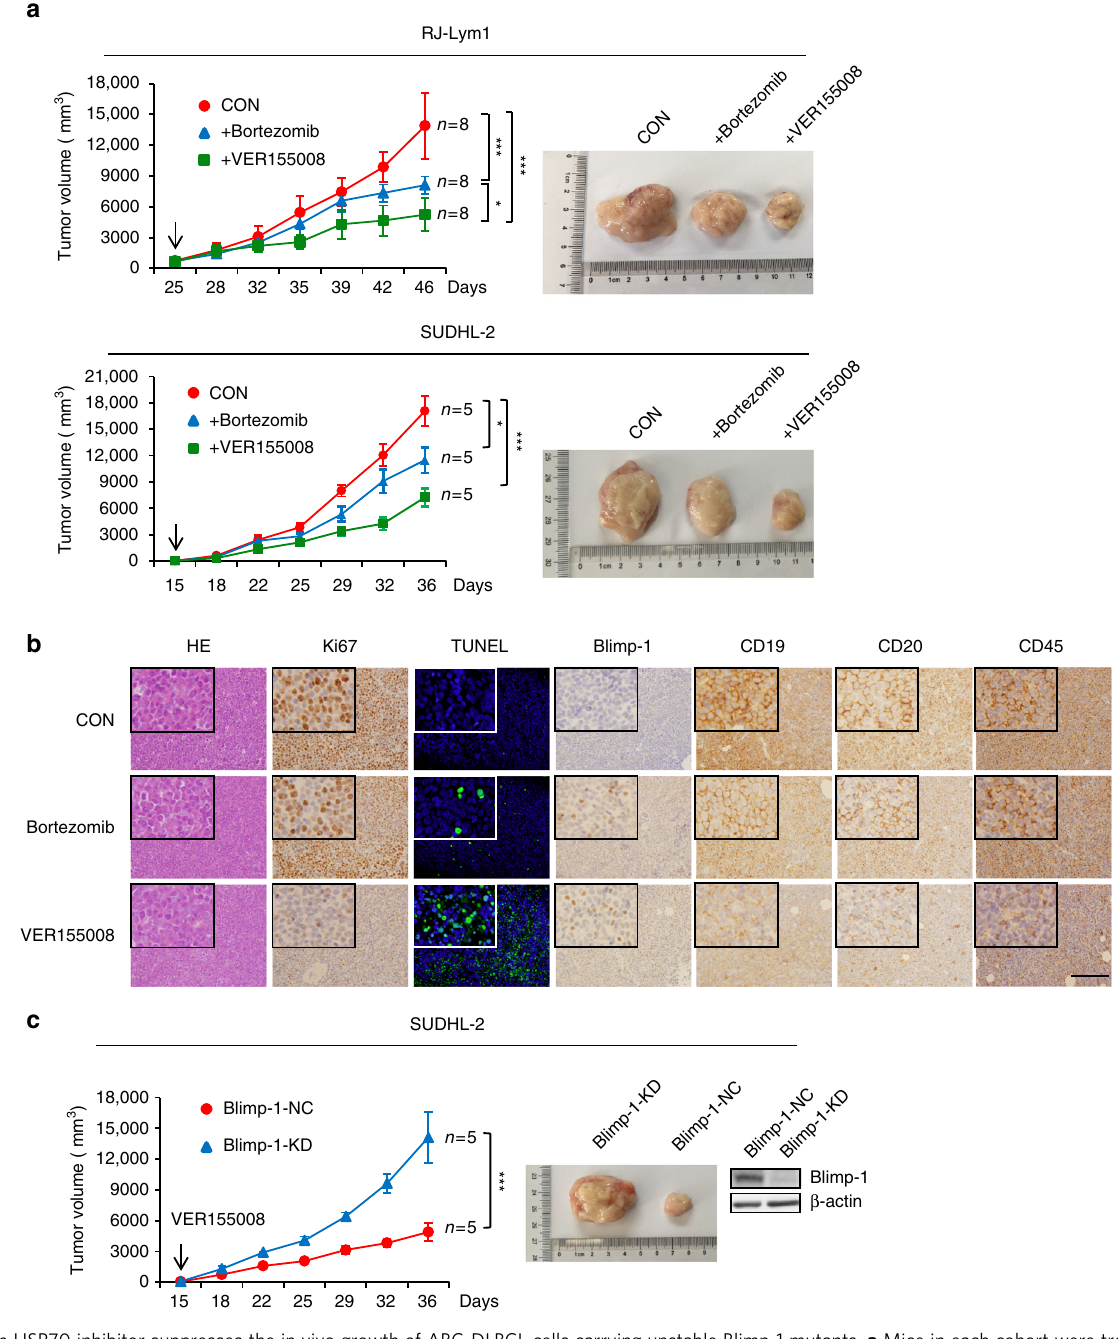
Fig. 7 An HSP70 inhibitor suppresses the in vivo growth of ABC-DLBCL cells carrying unstable Blimp-1 mutants. a Mice in each cohort were treated with PBS (CON), bortezomib (1 mg kg − 1 ) or VER155008 (40 mg kg − 1 ) twice weekly for 3 weeks. Tumor volumes were measured every 3 – 4 days. Treatment began on the day indicated with an arrow. The representative gross morphology of the tumors isolated from the control group, the bortezomib treatment group, and the VER155008 treatment group are shown in the right panel . b The expression of Ki67, Blimp-1, CD19, CD20, and CD45 in the retrieved RJ-Lym1 tumor samples from the different groups was examined by IHC staining. HE staining and a TUNEL assay were performed in parallel. Scale bar : 50 μ m. c SUDHL-2 cells stably transfected with control shRNA or with Blimp-1 shRNA were inoculated into NOD/SCID mice, which were treated with VER155008 (40 mg kg − 1 ) as in a , and tumor volumes were measured every 3 – 4 days. The representative gross morphology of the tumors isolated from two groups and the western blot for Blimp-1 expression are shown in the right panel . Data are represented as mean ± SD. *** P < 0.01, * P < Transfection of cDNAs and siRNAs . cDNAs encoding the human proteins fused cDNAs encoding SENP1, SENP6, SUMO1, SUMO-2, SUMO-3, PML, RNF4, PIAS1, PIAS2 α , PIAS2 β , PIAS3, PIAS4, and CBX4 were inserted into pCMV-AC- to fl ag, GFP, myc, mCherry or YFP at the C- or N-terminus were inserted in DDK. DNA plasmids were transfected into cells using Lipofectamine 3000 plasmids pCMV6-AC-DDK, pEGFP-N1, pcDNA3.0 (-) B, pmCherry-C1 or (Invitrogen). pEYFP-N1 to produce Blimp-1- fl ag, Blimp-1-GFP, fl ag-Blimp-1-GFP (1 – 206 aa), The siRNAs against PML , CBX4 , Hrd1 , HSP70 (HSPA5 , HSPA8 , and HSPA9) , SUMO-2 , SUMO-3 , and SENP1 were purchased from GenePharma (China), and the sense strand sequences were: PML , CCCGCAAGACCAACAACAUTT; CBX4 ,